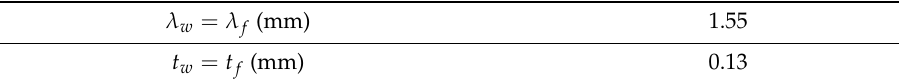
Figure 1. Fiber tow structure of plain weave textile composites. Table 1. Dimensions of fiber tows.